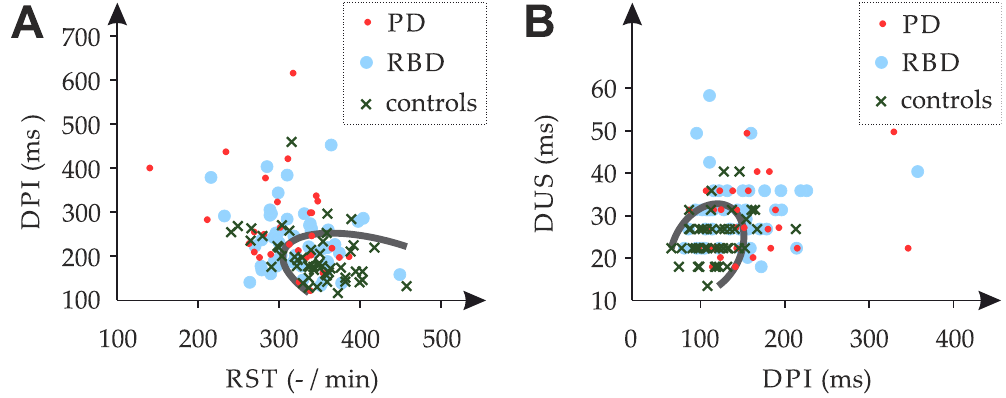
Figure 5. Selected pairs of representative acoustic features depicting the most distinctive speech pattern allowing differentiation between PD and controls. Individual speakers plotted in speech dimensions represented by ( A ) DPI in the monologue and RST in reading task, and ( B ) DPI in the reading task and DUS in monologue. The solid gray line represents the border of discrimination between speech negatives (subjects with unchanged speech performance) and speech positives (subjects with speech performance closer to PD speakers). The ‘.’ marks represent PD, ‘o’ for RBD and ‘x’ for controls. PD = Parkinson’s disease, RBD = rapid eye movement sleep behaviour disorder, DPI = duration of pause intervals, RST = rate of speech intervals, DUS = duration of unvoiced